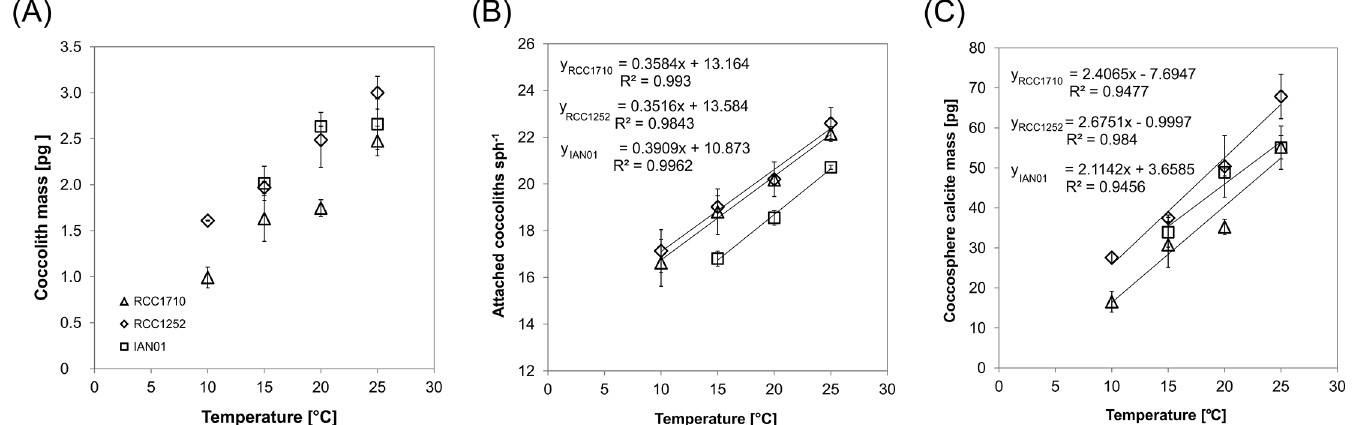
Fig 1. Temperature effect in the coccosphere calcite mass. The coccosphere calcite mass (C) was calculated from the coccolith mass (A) and the number of attached coccoliths per coccosphere (B). Standard deviations of the triplicate experiment results are shown. Linear trend lines, corresponding equations, and r-squared values are shown in Figs B and C. The following three different strains of E . huxleyi were used: RCC1710 (triangle symbols), RCC1252 (diamond symbols), and IAN01 (square symbols). Fig A is from Rosas-Navarro et al. [23].